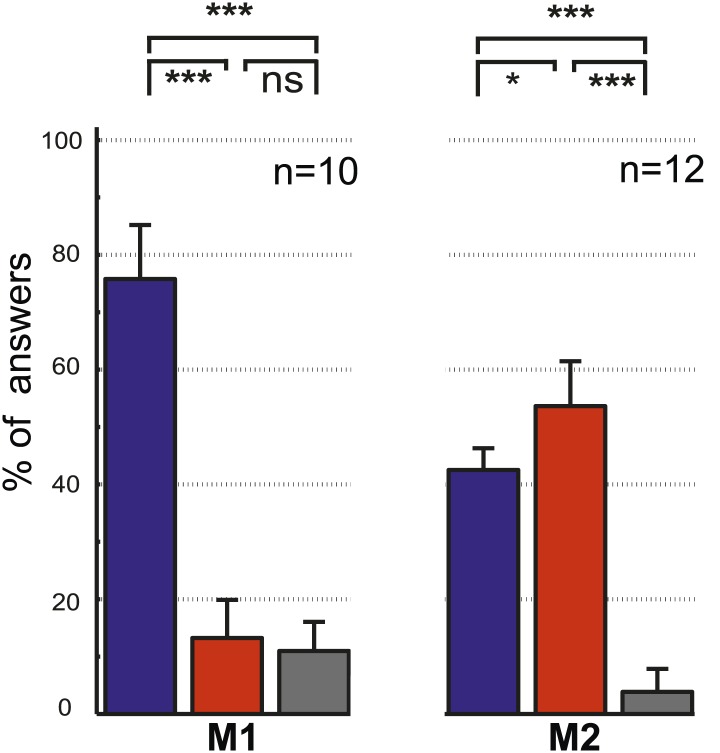
The results of the control experiment testing for associations between demonstrator's identity and the ordinal position of targets (Figure 2—figure supplement 2).Mean percentages of responses classified as falling in the 'learned order associations' category (blue column), the 'learned absolute spatial associations' category (red column), and the 'other' category (gray column). We found differences in the preferred categories between two observers (repeated measures one-way ANOVA [F2,18 = 170.9, p<0.001 (M1); F2,22 = 175.9, p=0.01 (M2)], post hoc pairwise comparisons [with Bonferroni correction] are presented on the graph with their significance levels: *p<0.05, **p<0.01, ***p<0.001, not significant [ns]. n indicates the number of experimental repetitions). Error bars represent standard errors. M1 = monkey 1, M2 = monkey 2.